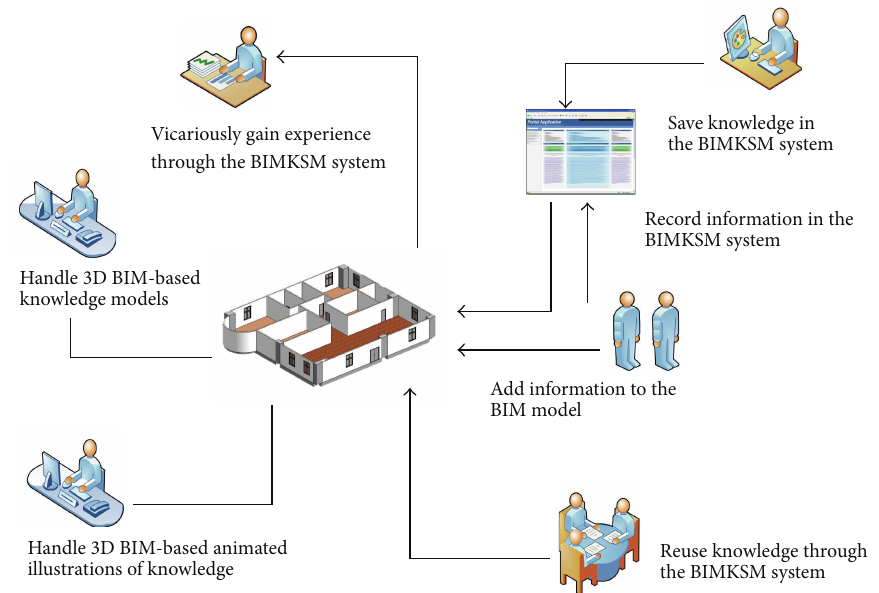
Figure 1: The application of the visual knowledge management in